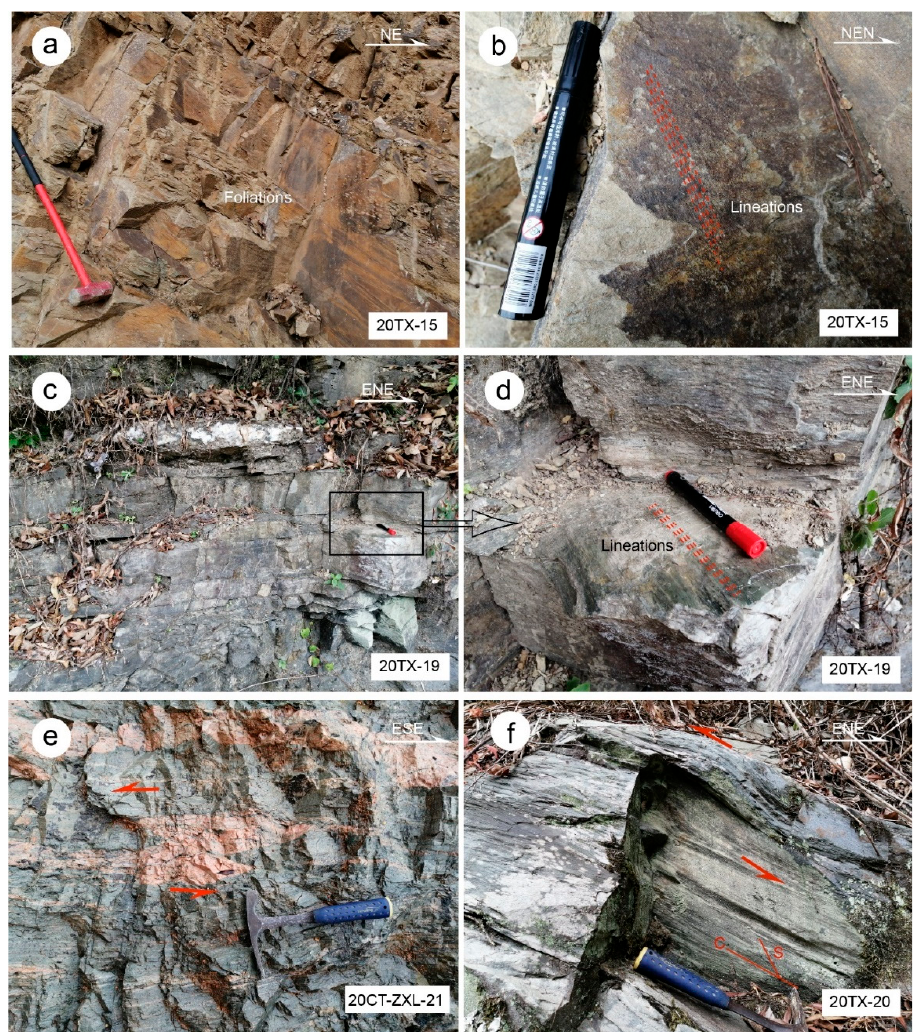
Figure 5. Outcrop photographs of structures at the NE–N domain of the Taoxi dome. ( a ) Felsic schist with NE-dipping foliations. ( b ) Stretching lineations developed. ( c ) Low-angle foliations. ( d ) Stretching lineations are downdip. ( e ) Syn-deformed dike indicates a sinistral sense of shear. ( f ) Foliation fish indicates a sinistral sense of shear. The red arrows show the shear sense.